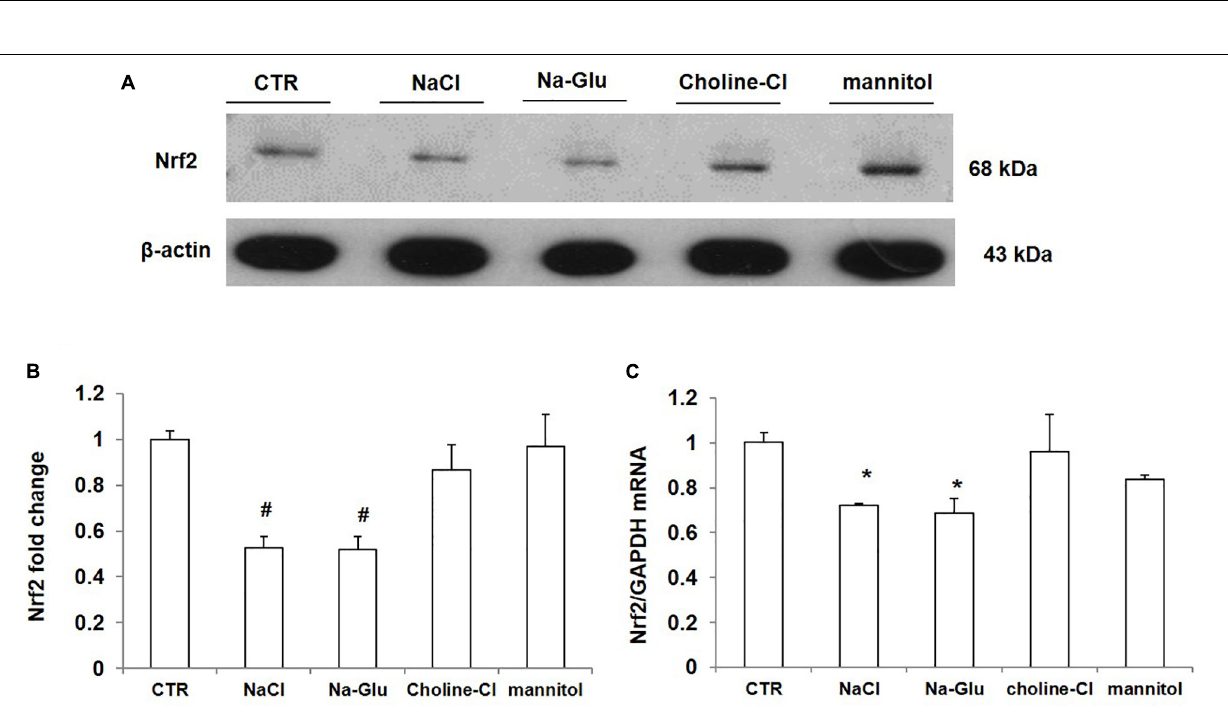
Frontiers in Physiology |